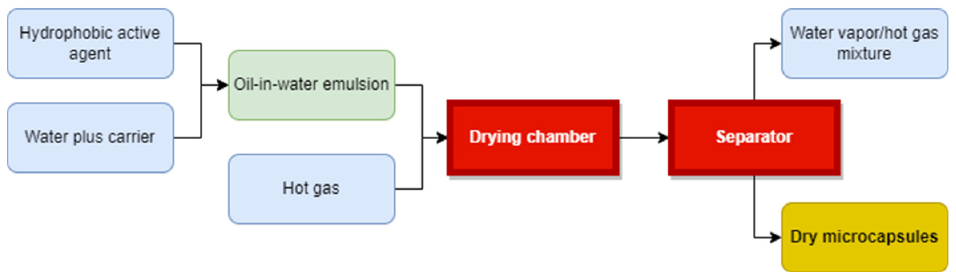
Figure 7. Spray drying microencapsulation method process flow, Mishra [114]. Microencapsulation by means of coacervation is another simple and efficient method for obtaining PCM microcapsules. The general design of the coacervation process is presented in Figure 6, Mishra [114]. Two types of coacervation process exist, Jamekhorshid [112]: (1) simple coacervation resulting from the interaction of a dissolved polymer with a low-molecular substance and (2) complex coacervation, which occurs through the interaction of two polymers with macromolecules bearing opposite charges. The coacervation process design, flows and equipment are presented in Figure 8, Mishra [114].